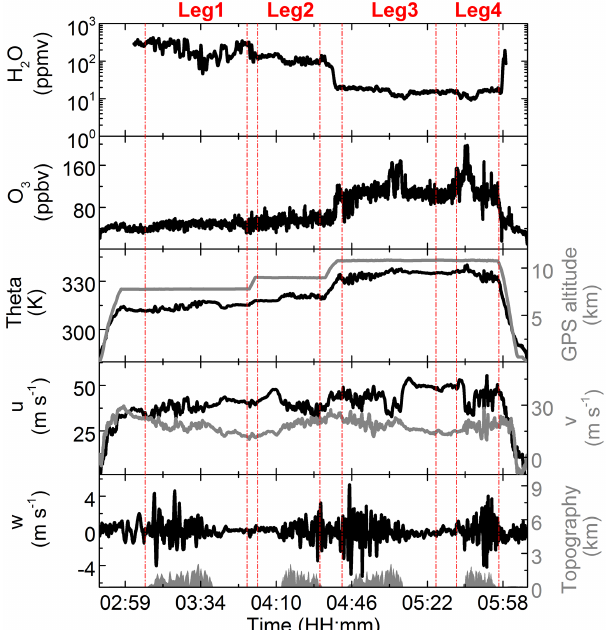
Figure 2. DLR Falcon flight FF04 on 4 July 2014 above the South- ern Alps: time series of observations during the mountain wave event. Water vapor mixing ratio (from CR-2), ozone mixing ra- tio, potential temperature and flight altitude (grey) as well as zonal wind, meridional wind (grey), vertical wind and topography (grey area at the bottom) are shown. Flight legs are separated by dashed red lines.